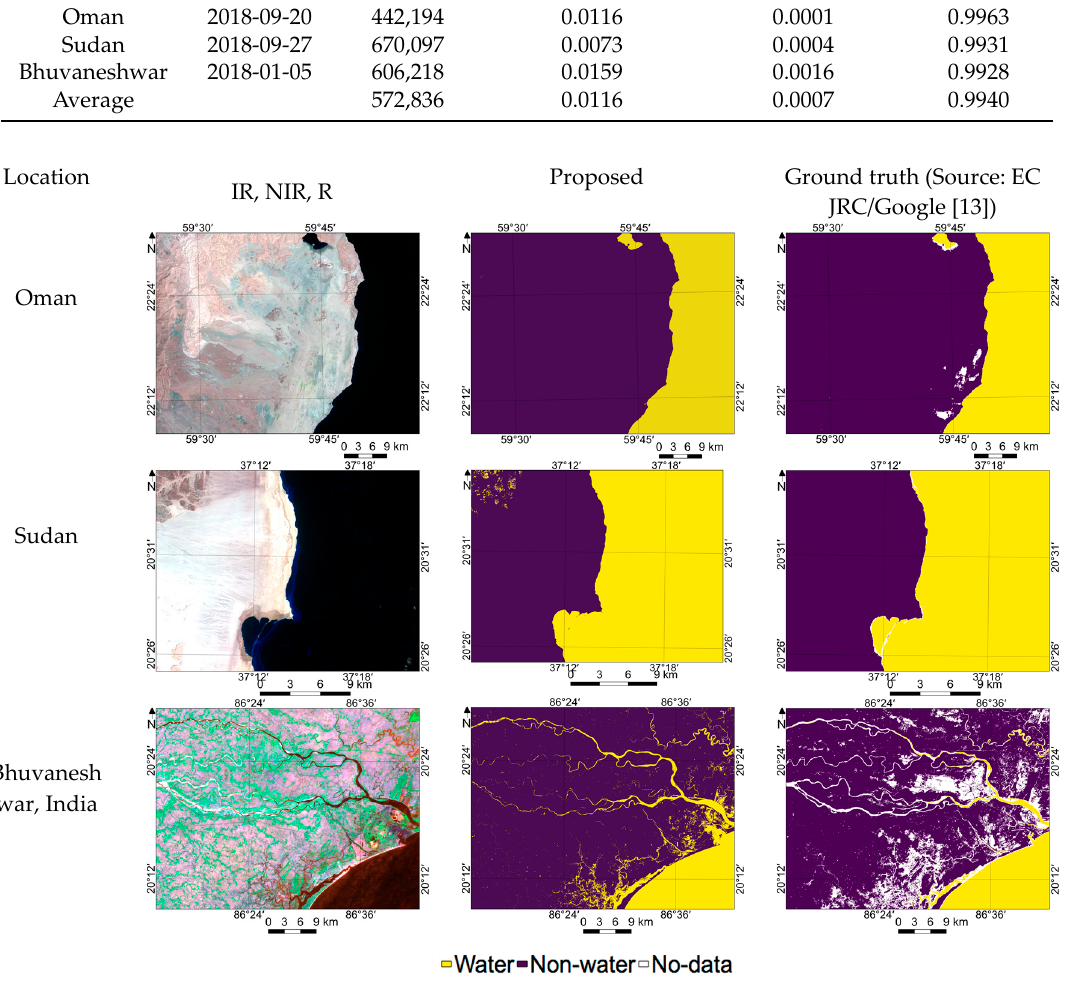
Figure 9. Demonstration of water region estimation using Sentinel-2 images over randomly selected locations.